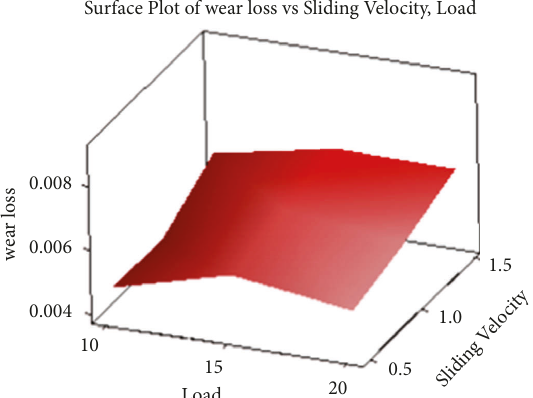
Figure 6: Surface plot graph for load % VS sliding velocity to wear loss.